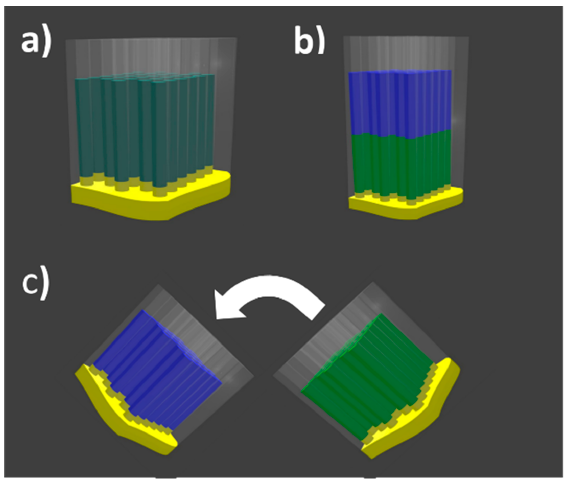
Figure 1. Schematic drawings of the different samples: ( a ) single element Ni or Co nanowire arrays; ( b ) coupled Ni/Co bi-segmented nanowire array; and ( c ) decoupled Ni/Co nanowire array where the arrow represents the direction of the arrays stacking. In all figures, the Ni and Co segments are green and blue respectively, while the Au bottom contact is yellow.